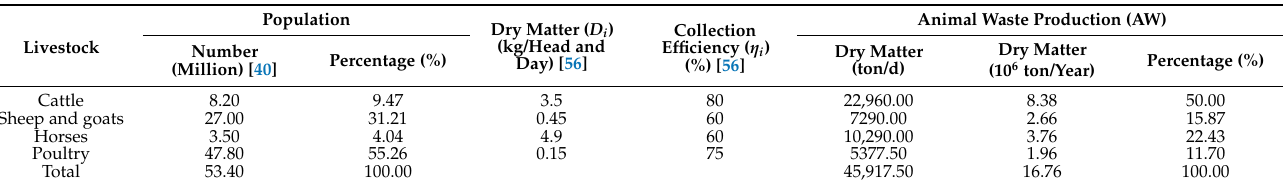
Table 2. Livestock breeding and potential waste